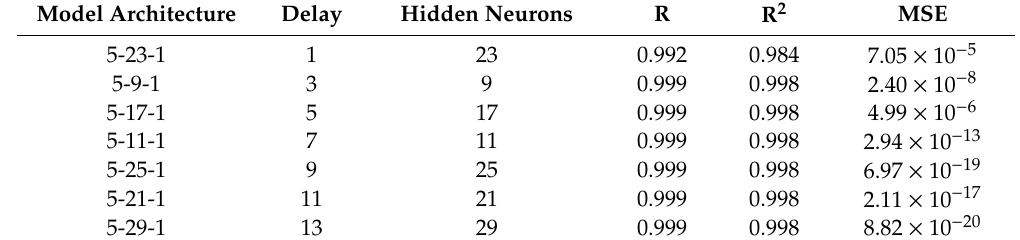
Table 5. Optimized hidden neuron obtained using data for Philippines. Model architecture